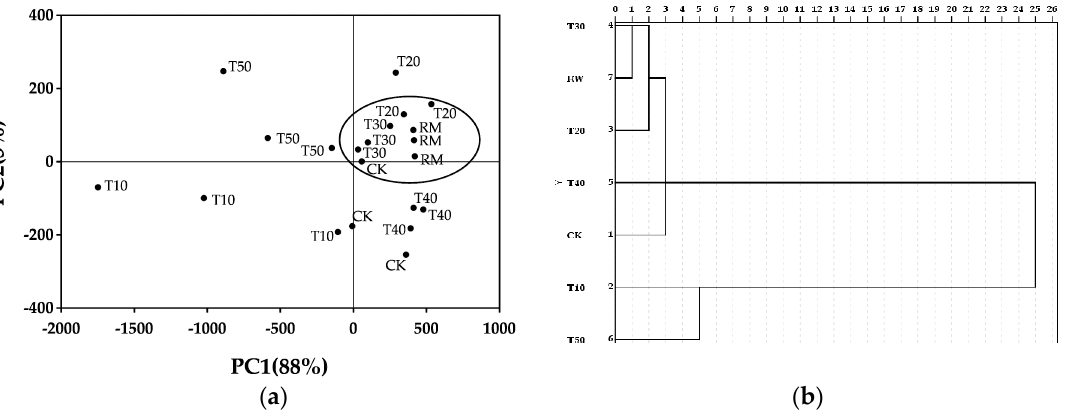
Figure 4. Classification of all skim milk samples preheated for di ff erent time: ( a ) Score plot after PCA of the samples. ( b ) Dendrogram from CA of the samples.